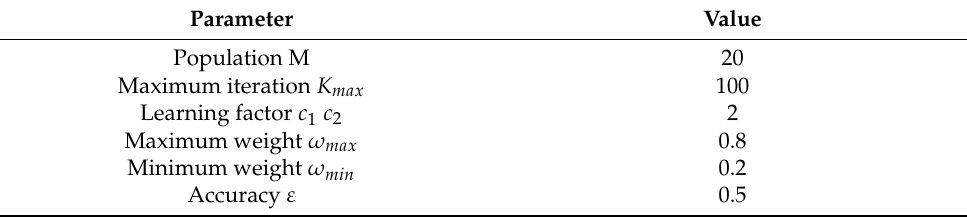
Table 4. Set parameters of the PSO algorithm.